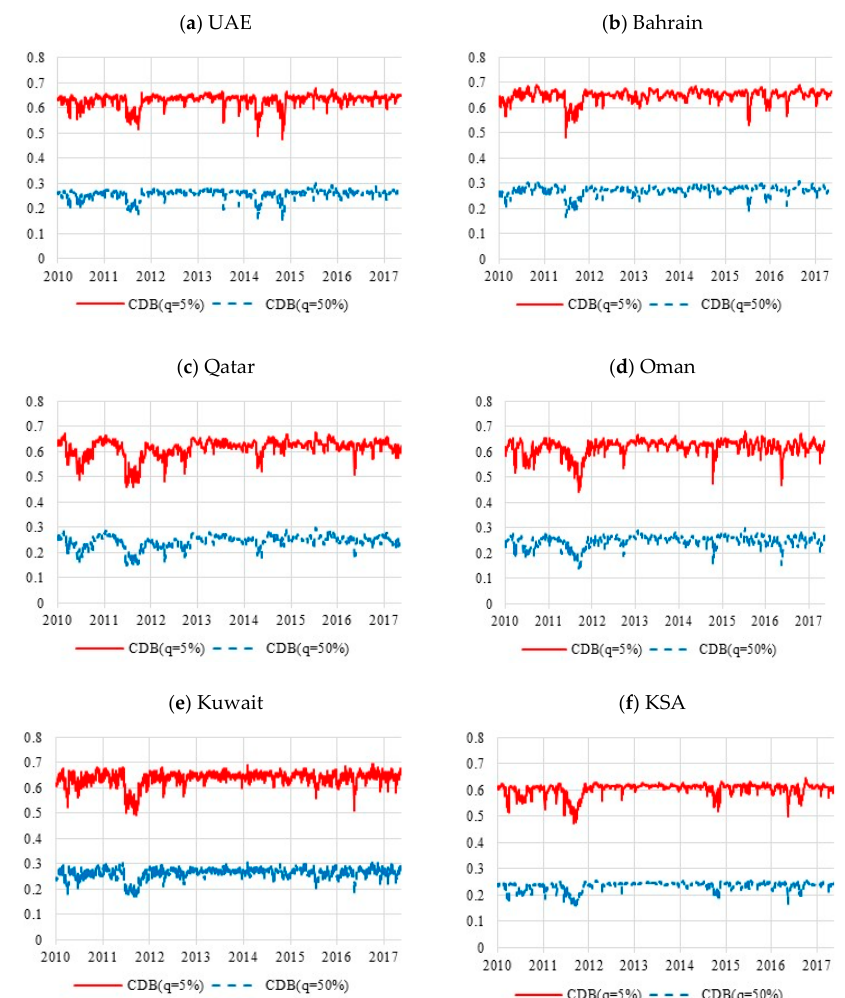
Figure 4. Time series plot of the conditional diversification benefits of GCCs for S&P 500 banking sector for equally-weighted portfolios: ( a ) UAE; ( b ) Bahrain; ( c ) Qatar; ( d ) Oman; ( e ) Kuwait; ( f ) KSA.